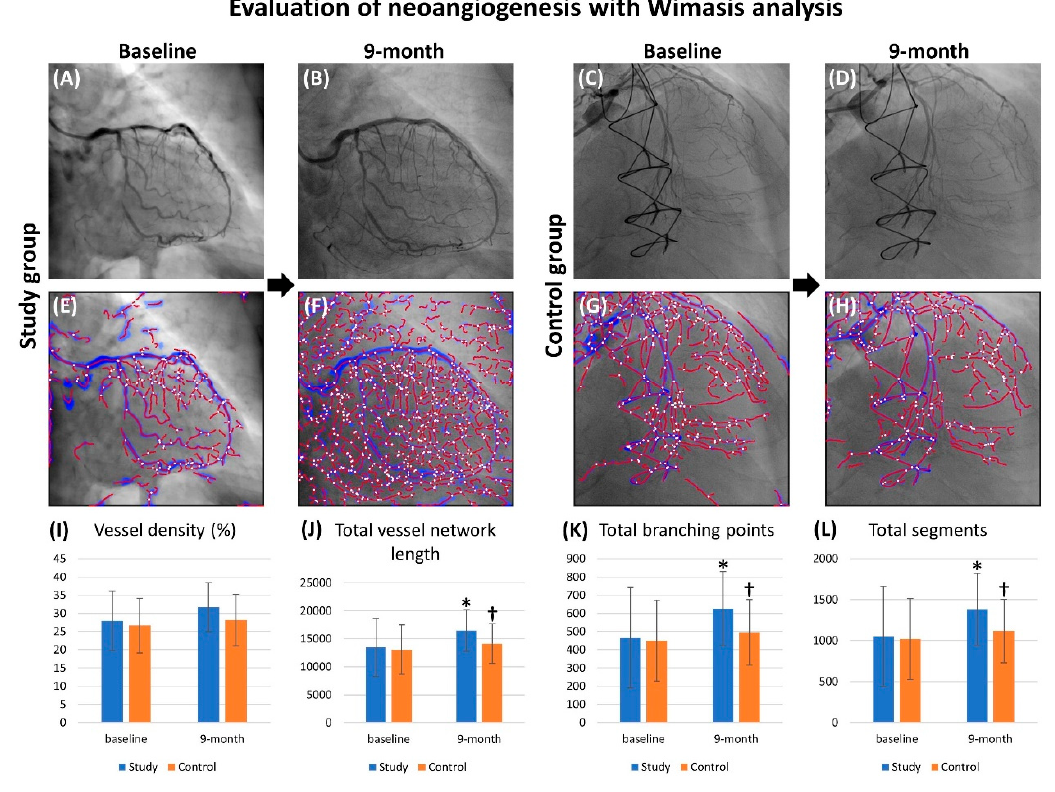
Figure 3. Illustrating the angiographic findings for identification of angiogenesis and Wimasis image analysis for assessment of angiogenesis. ( A ) and ( D ) Illustrating the coronary angiographic findings prior to ( A ), ( C ) and at 9th month ( B ), ( D ) after CD34+ therapy. As compared to control group ( D ), abundant angiogenesis/neovascularization were notably increased in study group ( B ) at 9th month after CD34+ therapy in both the same patients. ( E ) and ( H ) Illustrating regional microvasculature angiogenesis level in fixed territory assessment with Wimasis image software, between these two-time intervals in study group and control group. As compared to control group ( H ), plentiful angiogenesis/neovascularization (red color) were noted as having increased in study group ( F ) at 9th month after CD34+ therapy in both the same patients. ( I ) Wimasis assay for angiogenesis parameter of vessel density: (1) at baseline and (2) at 9th month, all p >0.5. ( J ) Wimasis assay for angiogenesis parameter of total vessel network length: (1) at baseline, p >0.5; (2) at 9th month, ∗ vs. †, p <0.05. ( K ) Wimasis assay for angiogenesis parameter of total branch point: (1) at baseline, p >0.5; (2) at 9th month, ∗ vs. †, p <0.05. ( L ) Wimasis assay for angiogenesis parameter for total segments: (1) at baseline, p >0.5; (2) at 9th month, ∗ vs. †, p <0.05.